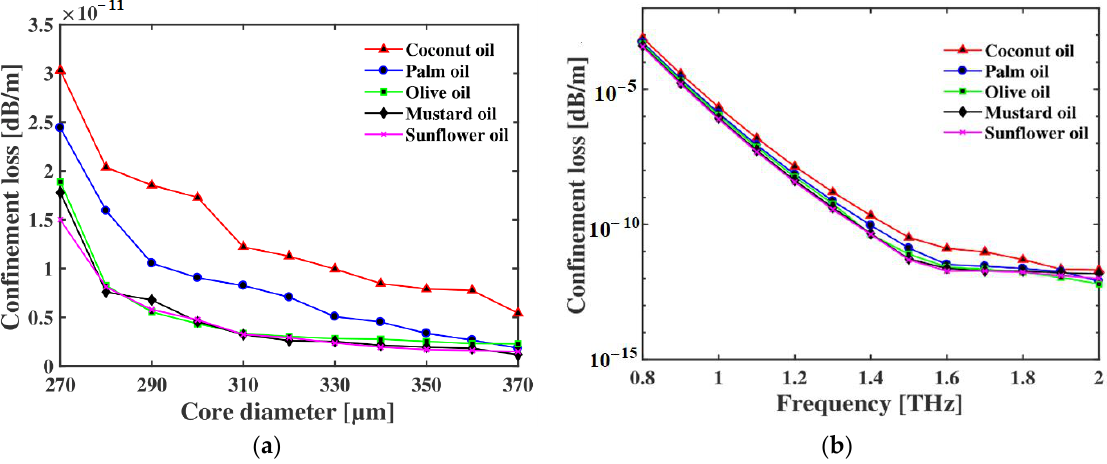
Figure 5. Confinement loss (CL) characteristics of the proposed oil detector for ( a ) different core diameters at 1.6 THz and ( b ) different values of frequencies at 340 µm core diameter. As stated earlier, the EML and CL are the two primary losses in PCF-based sensors.